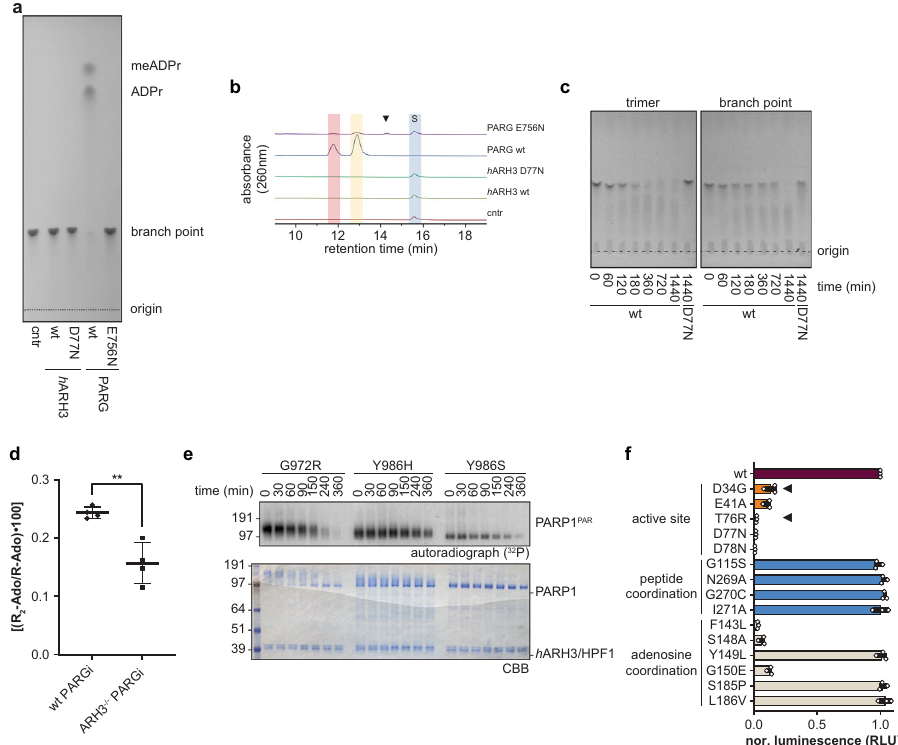
Fig. 5 PAR branching impairs the glycohydrolase activity of ARH3. a Synthetic PAR trimer degradation by ARH3 and PARG. Samples were analysed by thin-layer chromatography (TLC) and representative results of three independent experiments are shown. b UV-visible chromatograms of LC-HRMS analysis of samples represented in ( a ). S, PAR branch point and black triangle, PARG E756N speci fi c peak. Full analysis is shown in Supplementary Fig. 2. c Time-course of synthetic PAR trimer and branch point degradation by h ARH3. Samples were analysed by TLC and representative results of two independent experiments are shown. d PAR branching levels in wt or ARH3 − / − U2OS cells. Wt and ARH3 − / − U2OS cells were treated with 25 µ M PARGi for 4 days. Afterwards, the di-ribosyl-adenosine to ribosyl-adenosine (R 2 -Ado/R-Ado) ratio was quanti fi ed by UPLC-MS/MS analysis (see ‘ Methods ’ ). Data are shown as mean ± s.d. of biological quadruplicates, ** p < 0.0032 (unpaired, two-tailed t -test). e Time-course of hydrolysis of enzymatic Ser- PARylation by h ARH3. To achieve Ser-PARylation PARP1 mutants were modi fi ed with 32 P-NAD + in presence of HPF1. Shown are representative results of three independent experiments. f Hydrolysis of Ser-MARylation by h ARH3 wt and mutants using H2BS7mar peptide as substrate. Brie fl y, the released ADPr was converted by NUDT5 to AMP, which in turn was detected by chemical luminescence using the AMP-Glo ™ assay (Promega; see ‘ Methods ’ ). Samples are background corrected and normalised to wt. Data are presented as mean values ± s.e.m. from three independent replicates measured in triplicates. COSMIC database-derived mutations are indicated by black triangle. Samples were analysed by SDS-PAGE followed by Coomassie Brilliant Blue (CBB) staining and autoradiography. Source data are provided as a Source data fi